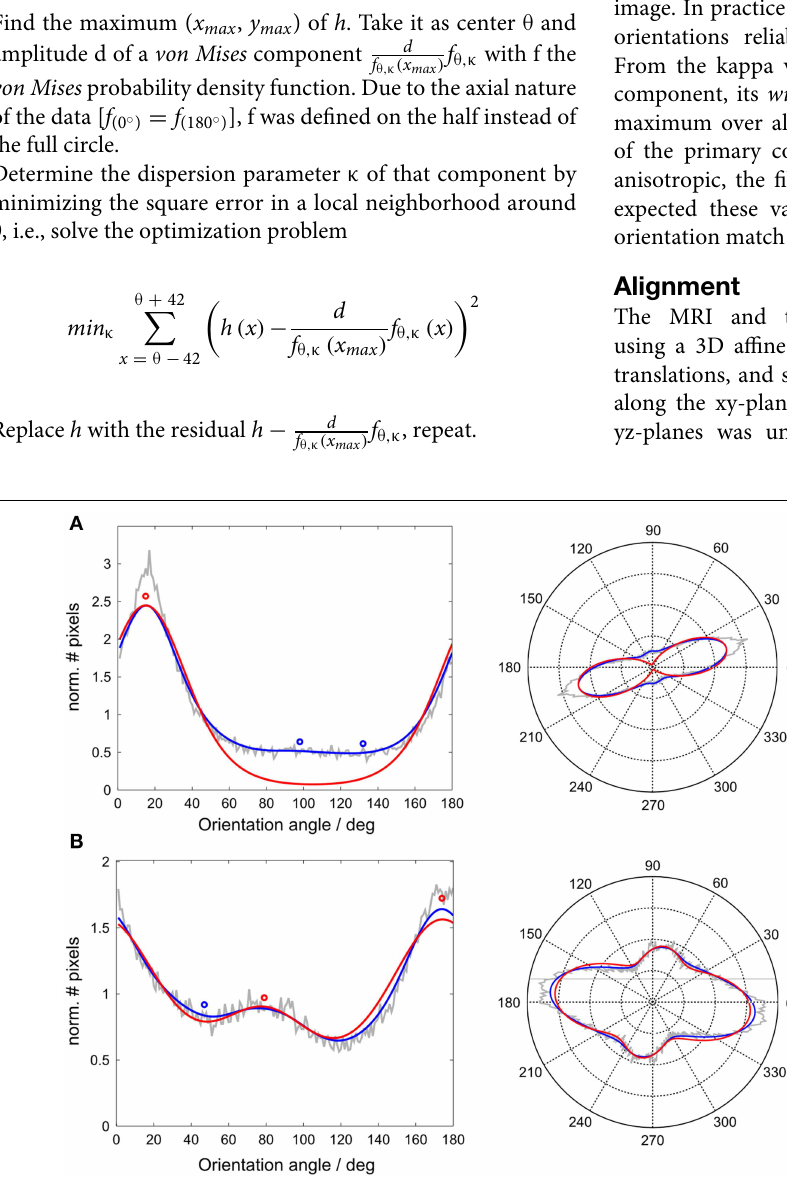
FIGURE 1 | Histological fiber orientation distribution with fitted von Mises mixture for two exemplary voxels. Left: Normalized histograms of structure tensor orientations of all pixels within a voxel (gray line), smoothed with a Gaussian window (blue line) and fitted using a mixture of three von Mises probability density functions (red line). The central